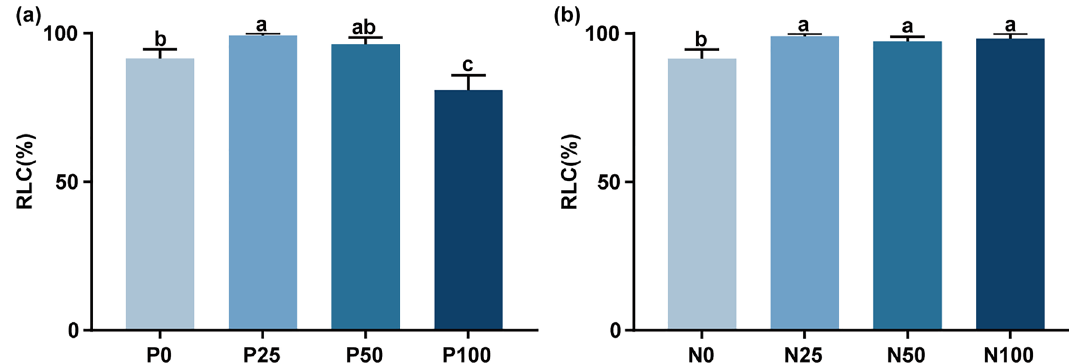
Figure 1. Mycorrhizal colonization of S. miltiorrhiza inoculated with G. versiforme affected by the addition of P ( a ) and N ( b ) fertilizer. ( a ) The P0, P25, P50, and P100 treatments represent the four levels of P fertilizer application (0, 25, 50, and 100 mg P fertilizer added per kilogram of soil, respectively). ( b ) The N0, N25, N50, and N100 treatments represent the four levels of N fertilizer application (0, 25, 50, and 100 mg N fertilizer added per kilogram of soil, respectively). Percentage of root length colonized (RLC, %) is expressed as the percentage of root length occupied by mycorrhizal fungal structures such as hyphae, arbuscules, and/or vesicles. Means ± standard errors are shown (n = 6). Different lowercase letters indicate significant differences between different treatments according to one-way ANOVA followed by followed by Tukey’s test for